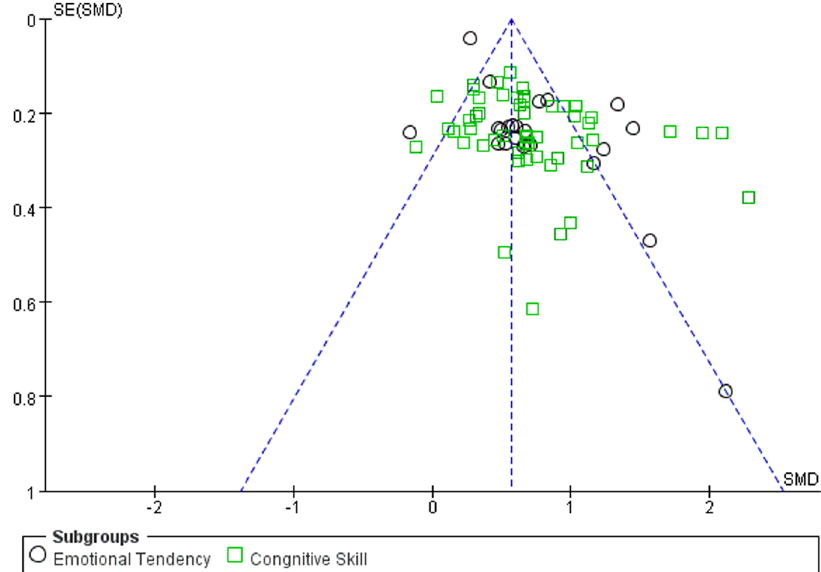
Fig. 2 Funnel plot showing 79 effect quantities across 36 studies with relation to publication bias. This funnel plot shows the result of publication bias of 79 effect quantities across 36 studies.